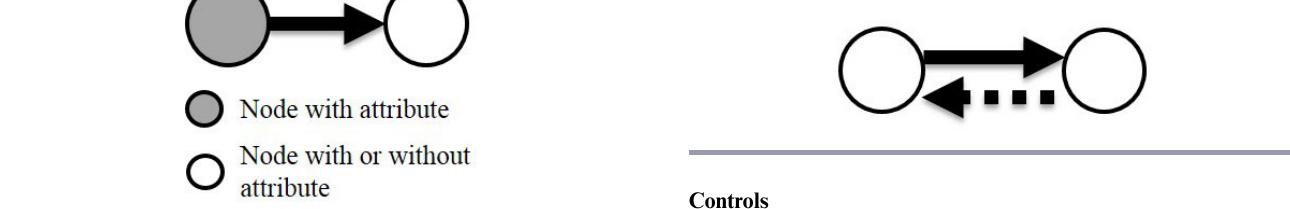
Fig. 5 . Coordination tie based on